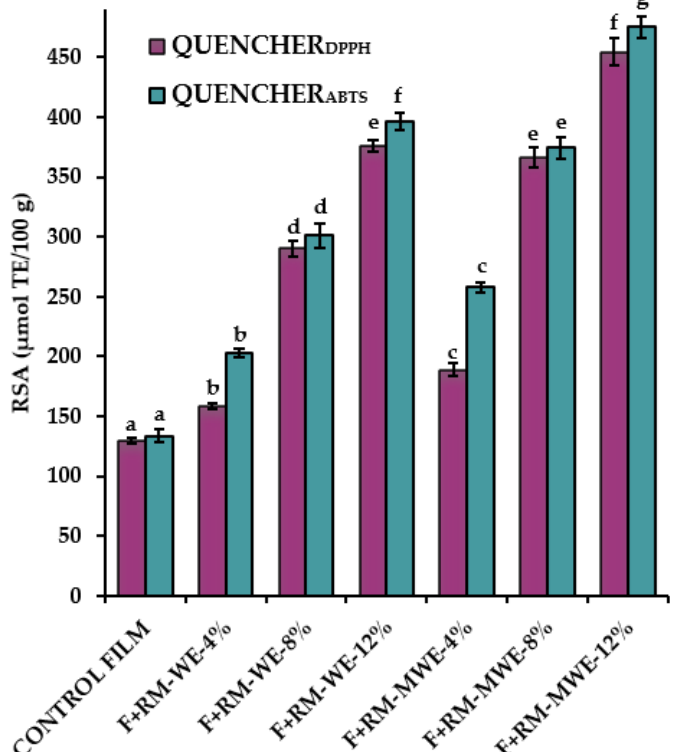
Figure 4. Radical scavenging properties of the prepared films determined by QUENCHER DPPH and QUENCHER ABTS methods. Bars with different letters (a–g) represent statistical differences (one-way ANOVA and Duncan test, p < 0.05) between radical scavenging activity of gelatin films with RM-WE and RM-MWE.